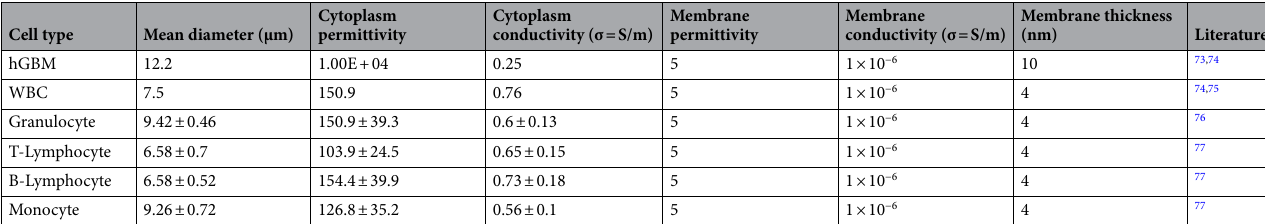
Table 1. Physical and electrical properties of cells used in the proposed technique. These parameters were directly accounted for in our model and resulting computation.